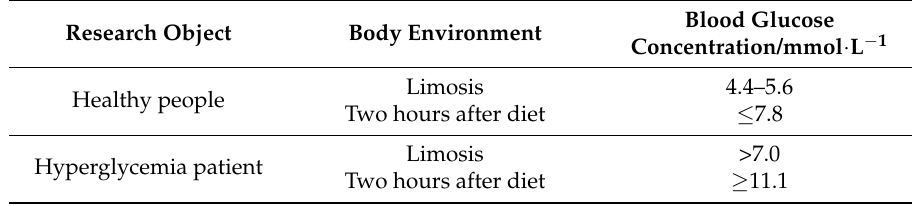
Table 1. The range of blood glucose concentration for healthy people and hyperglycemia patient